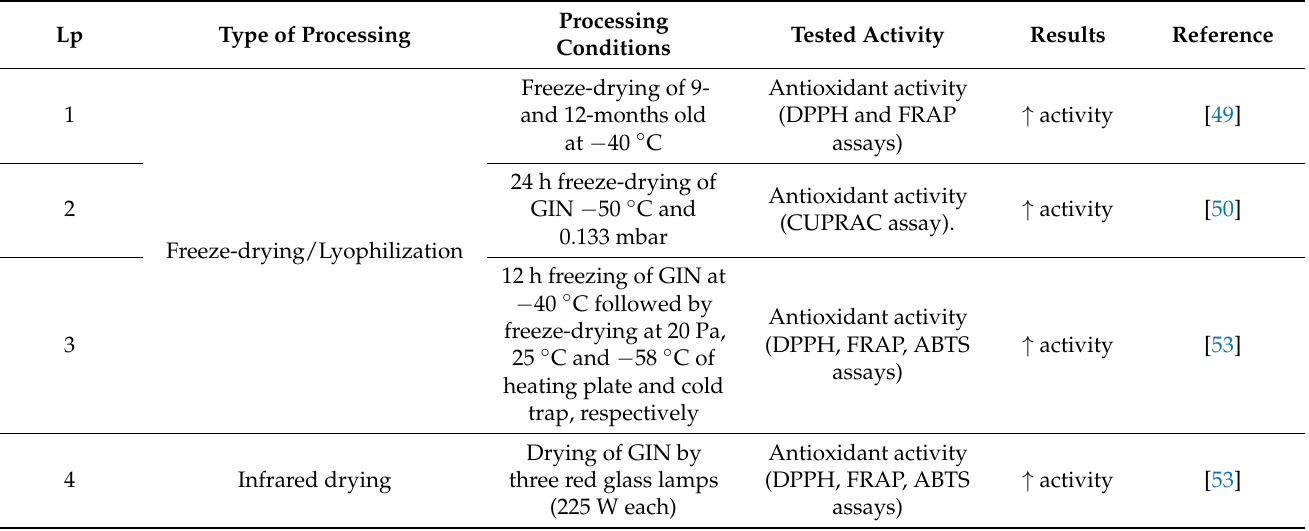
Table 2. Effect of freeze-drying and infrared drying (unconventional methods) on pharmacological activity of